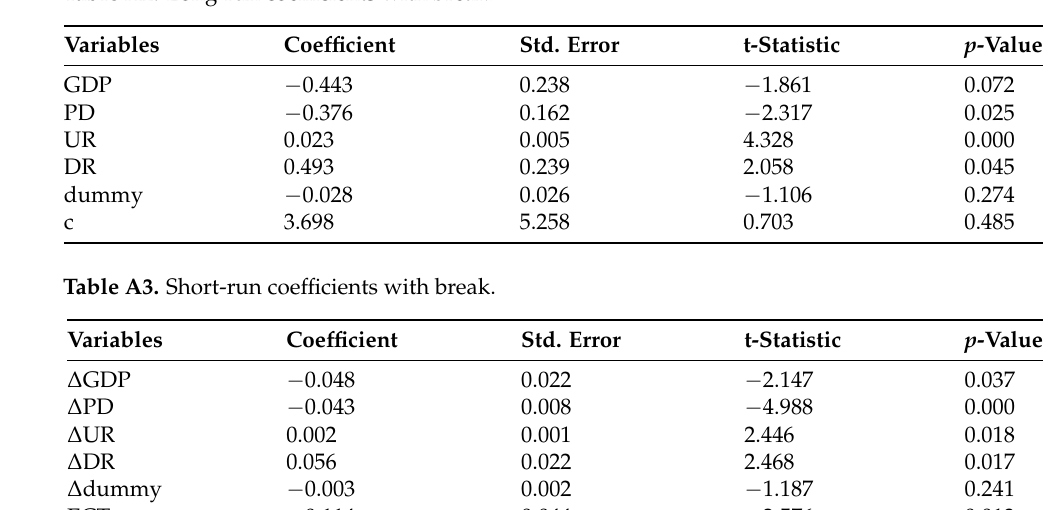
Table A2. Long-run coefficients with break.